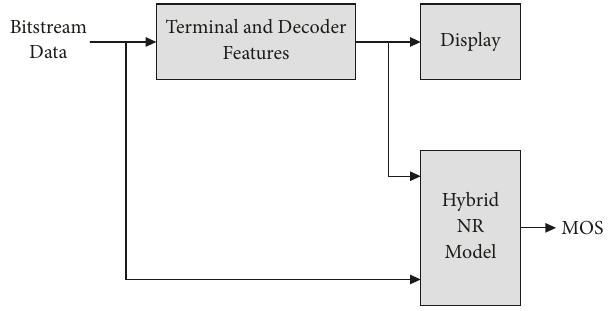
Figure 24: Block diagram of hybrid NR models.